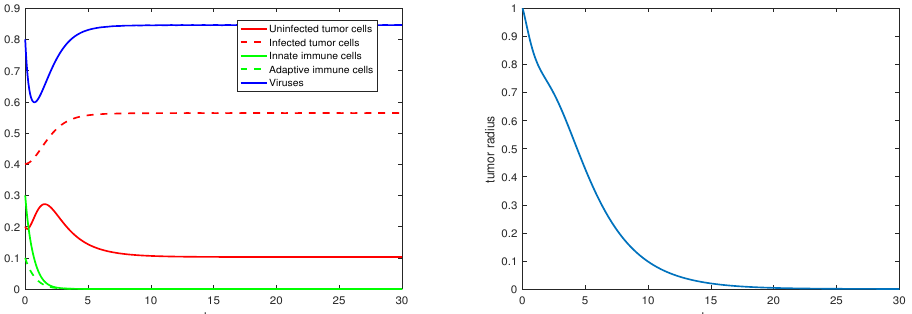
Figure 5. The equilibrium I 0 = ( 0.10,0.56,0,0,0.84 ) is asymptotically stable and the tumor radius is exponentially decreasing when δ < µ and 1 < R 0 = 1.50 < min { µ The values of the parameters are: λ = 2, β = 3.5, k 1 = 1, k 2 = 2, s 1 = 2, s 2 = 1.5, c 1 = 3, c 2 = 2.5, δ = 1.5, k 0 = 1.5, γ = 2.5, µ = 3.5, b =